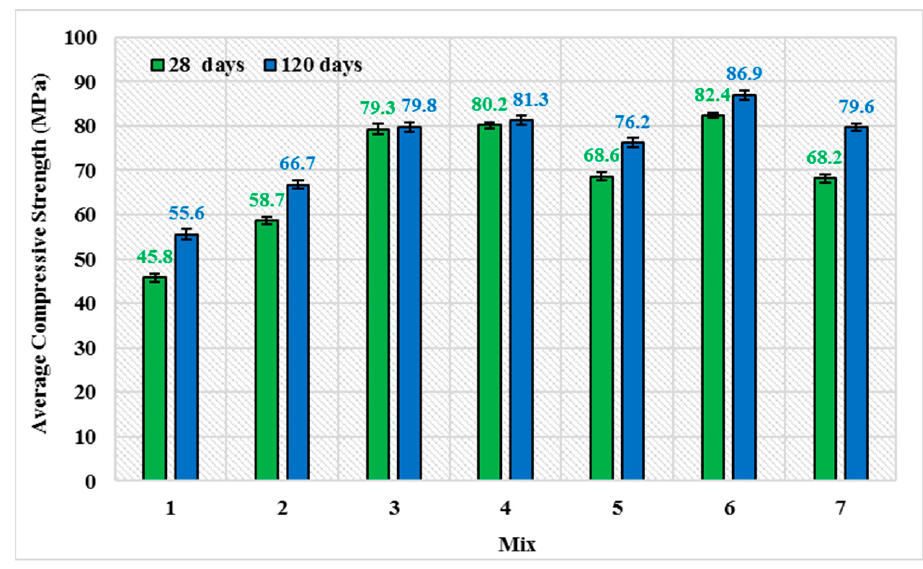
Figure 4. Effect of SF and water magnetization method on concrete compressive strength.